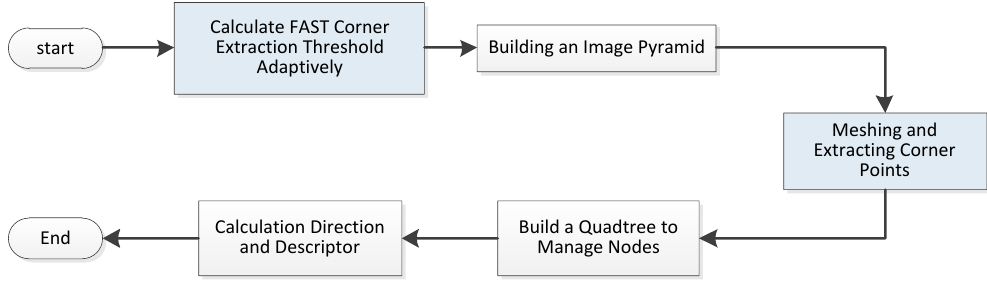
Figure 5. Flow chart of improved ORB algorithm.